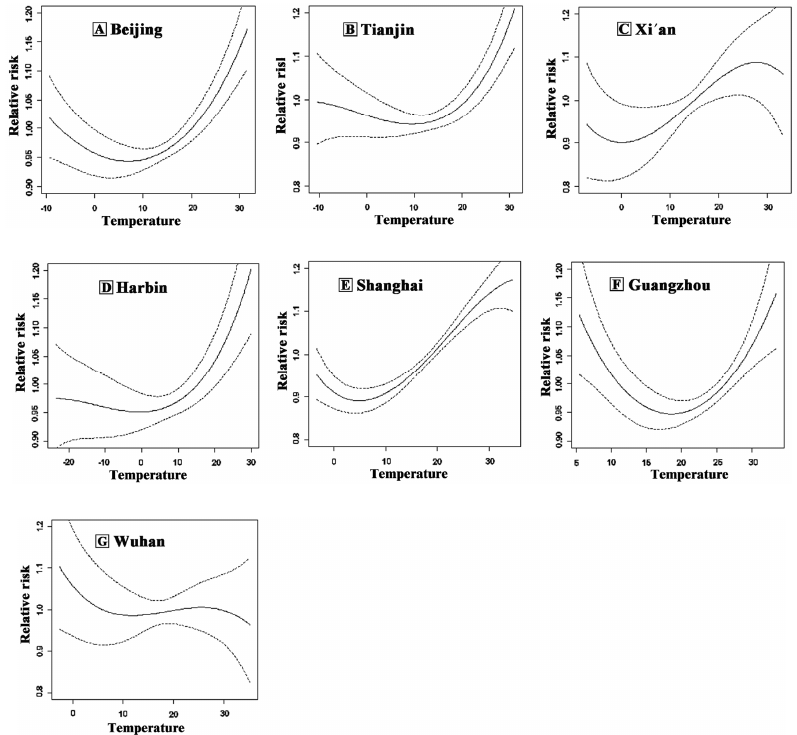
Figure 1. Exposure-response curve between temperature and non-accidental mortality for ( A ) Beijing; ( B ) Tianjin; ( C ) Xi’an; ( D ) Harbin; ( E ) Shanghai; ( F ) Guangzhou; and ( G ) Wuhan, China, 2007–2009. The solid lines represent the estimated relative risk in daily non-accidental mortality and the dotted lines represent the 95% confidence interval for each estimate. Table 3. Acute effects of ambient temperature on non-accidental mortality in different levels of seven large cities in China.